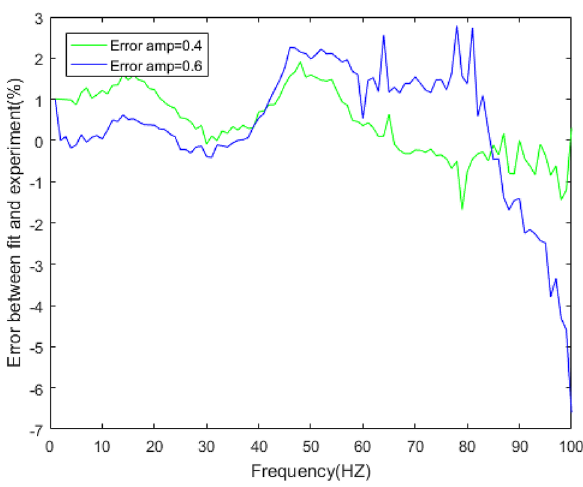
Figure 26. Errors of loss factor between five-parameter mathematical model and experiment under amplitude 0.4 mm, 0.6